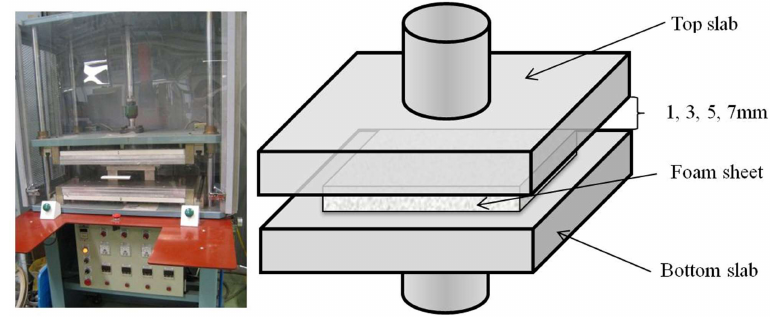
Figure 1. The experimental setup of the moulding